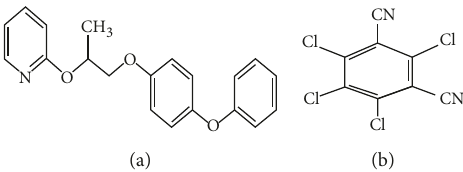
Figure 1: The chemical structure of (a) pyriproxyfen and (b)